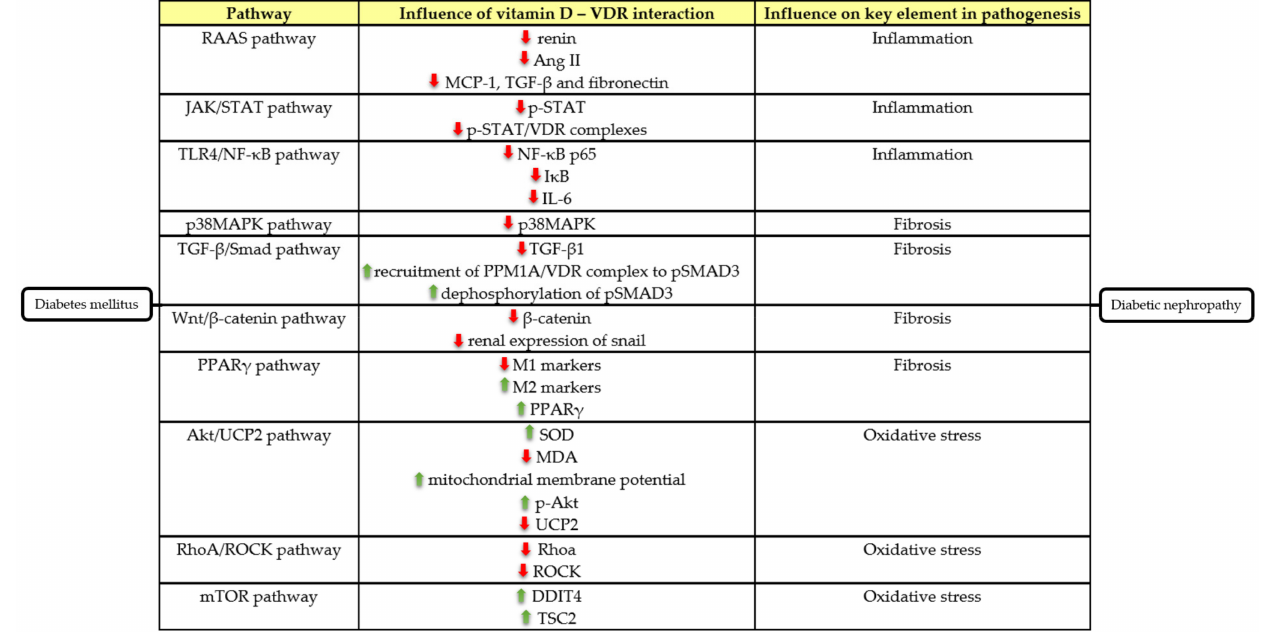
Figure 1. Underlying molecular mechanisms explaining the potential renoprotective capacity of vitamin D in diabetic